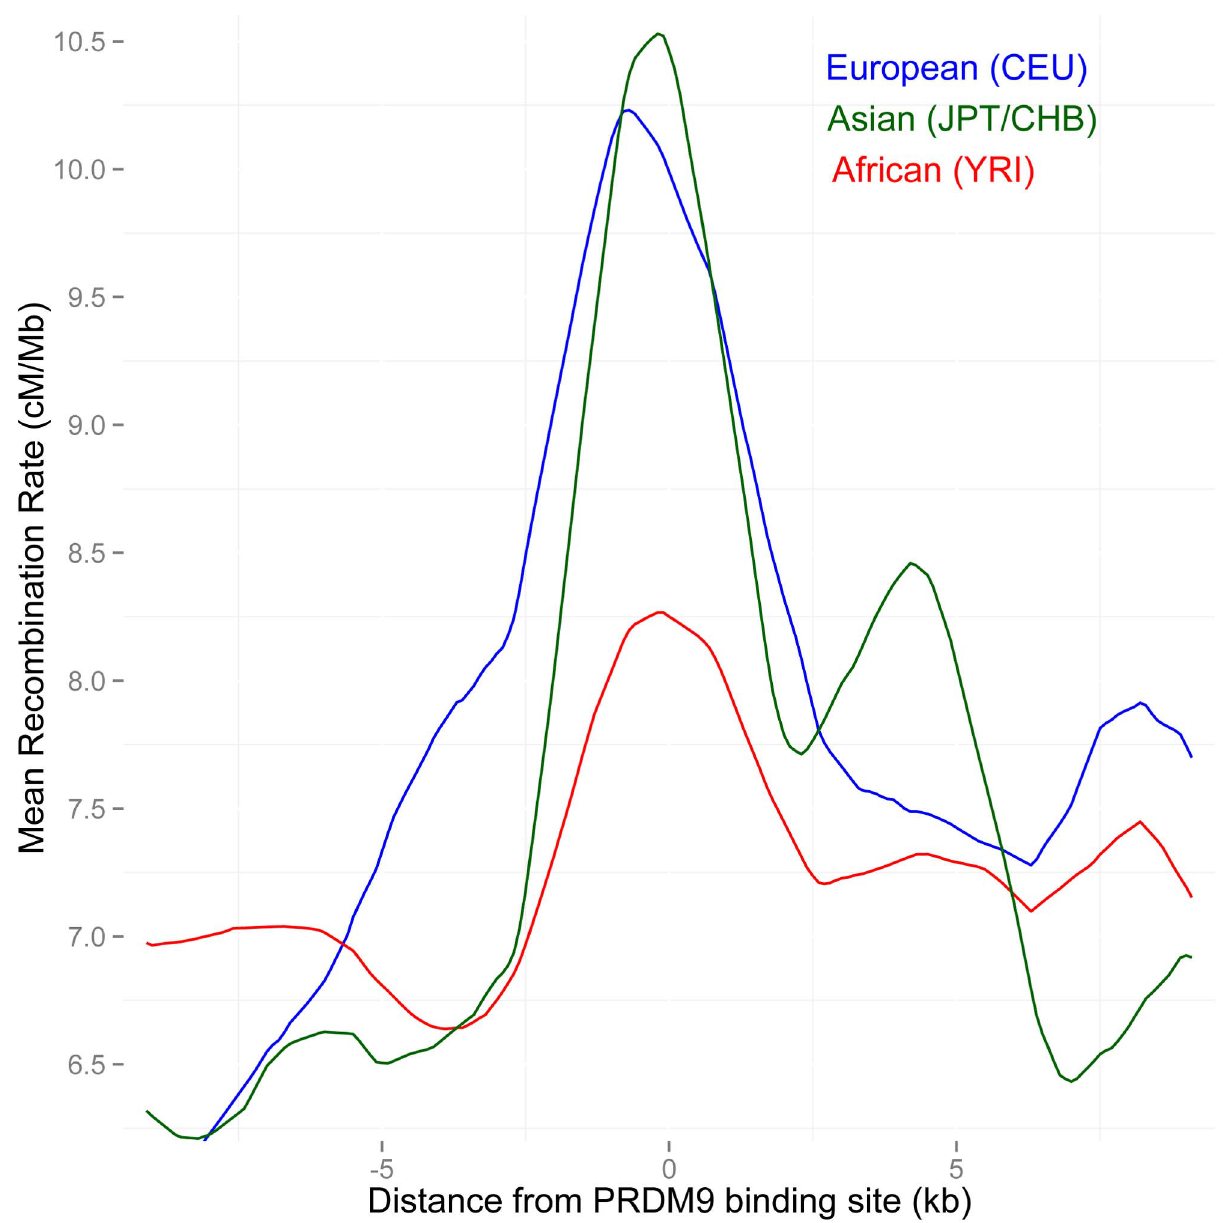
Figure 4. Separate LD-based recombination rates in PAR1 in three human continental groups, around the binding sites of the PRDM9 B allele. The B and other alleles predicted to bind similar motifs predominate in Europe and East Asia (91% frequency), but not in Africa (58% frequency). In PAR1, the recombination pattern is consistent with being activated by PRDM9, as both Asian and European populations show a much stronger increase in rate at these binding sites than Africans ( P =0.002 African/Asian, P =0.02